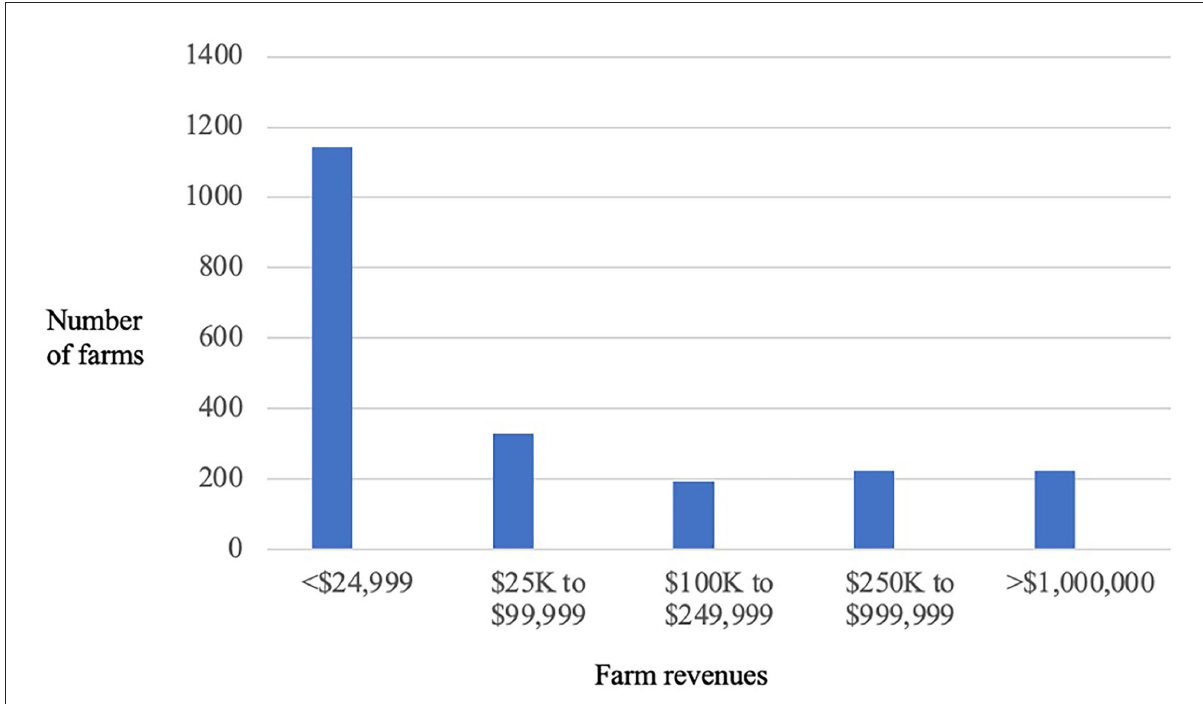
FIGURE4 Farm revenue distributions across the Metro Vancouver region, Canada (Statistics Canada,